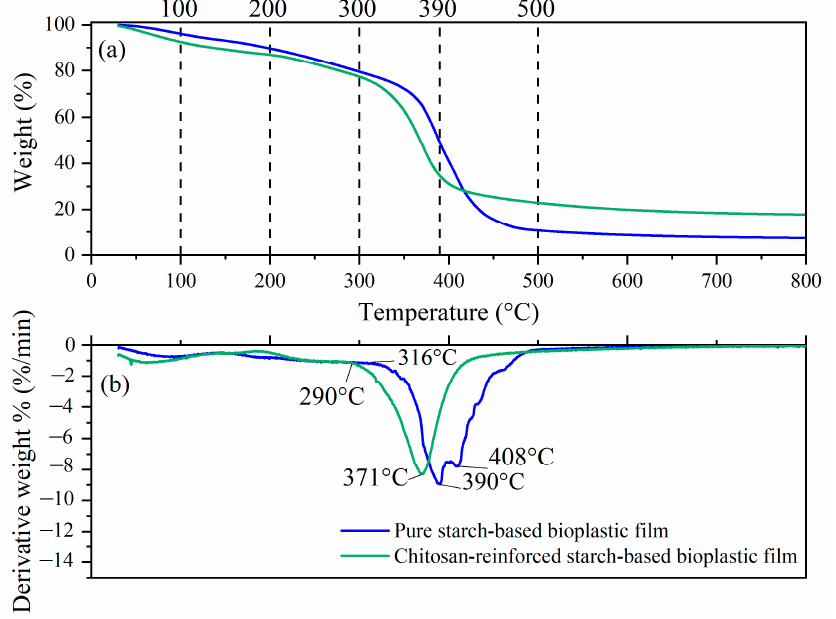
Figure 12. ( a ) TGA and ( b ) DTG curves of pure starch-based and chitosan-reinforced starch-based bioplastic films.